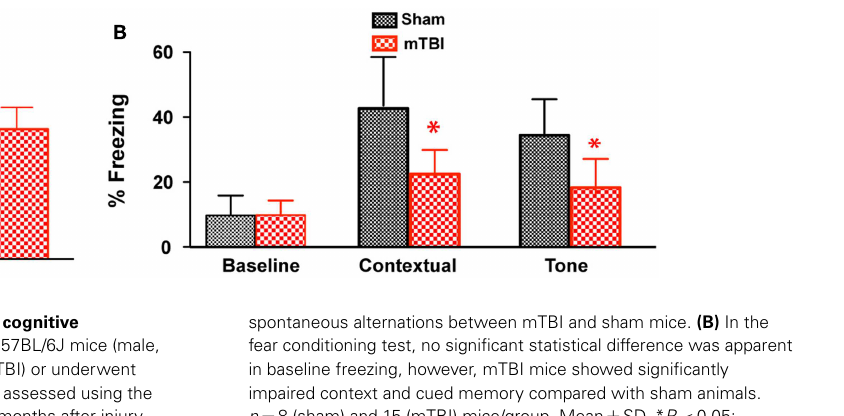
FIGURE 6 | Repetitive mTBI causes significant cognitive impairments 6months after injury .Wild-type C57BL/6J mice (male, 3months of age) received three mild impacts (mTBI) or underwent sham procedures (sham). Cognitive function was assessed using the Y-maze (A) and contextual fear conditioning (B) 6months after injury. (A) In theY-maze test for working memory, there was no difference in